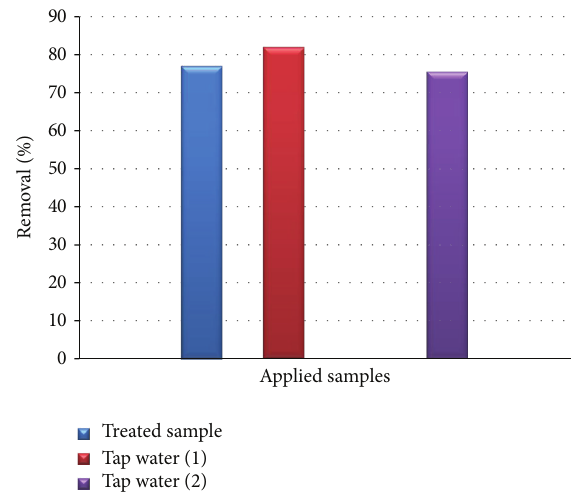
Figure 8: Removal percentage of Cu (II) from Tap water samples.